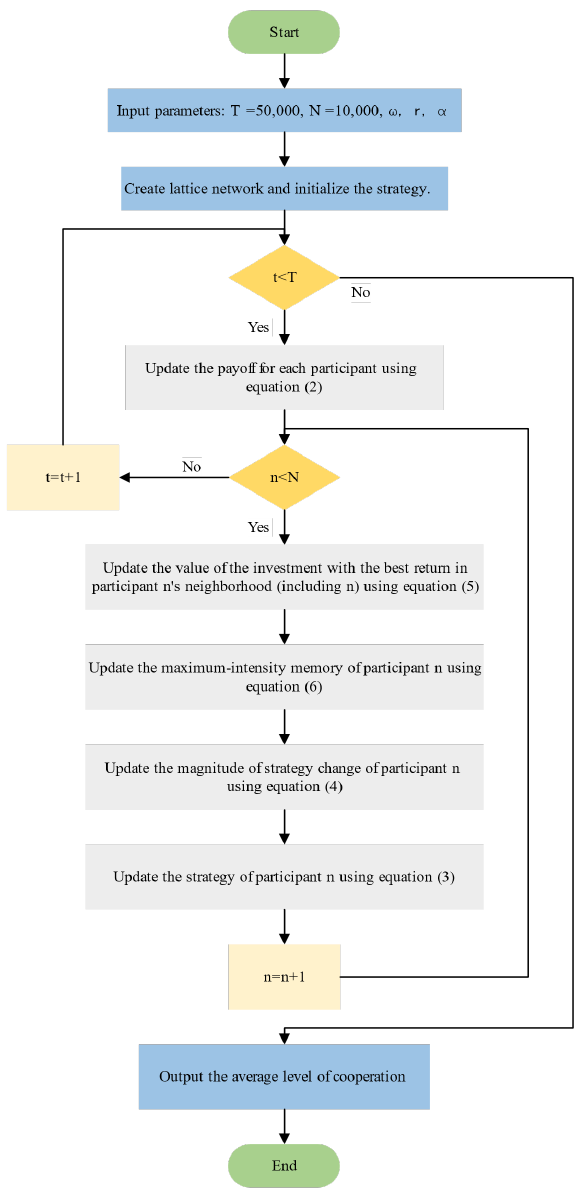
Figure 3. Algorithm flow chart.